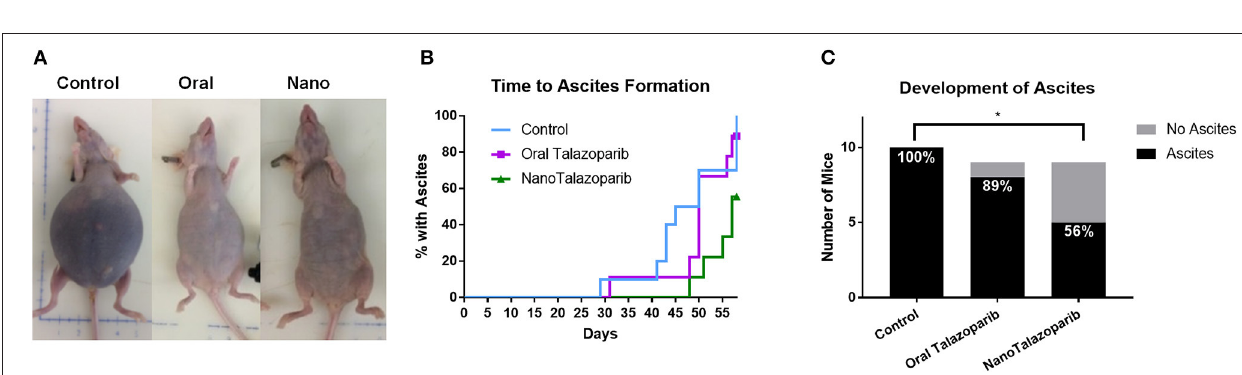
FIGURE 3 | (A) Bioluminescence imaging allows for monitoring disease progression throughout the treatment period ( n = 10 for control and n = 9 for treated groups). (B) Luminescence over time is displayed in representative images for each cohort throughout the course of the study. (C) The aggregate tumor weight for each animal at the end of the 8-week treatment period confirms final tumor burden ( n = 8 for control and n = 9 for treated groups). (D) No evidence of gross toxicity was observed as measured by the percent change in bodyweight ( n = 10 in control group and n = 9 in treated groups). Statistical significance was determined using two way ANOVA followed by Tukey’s test, * p < 0.05.